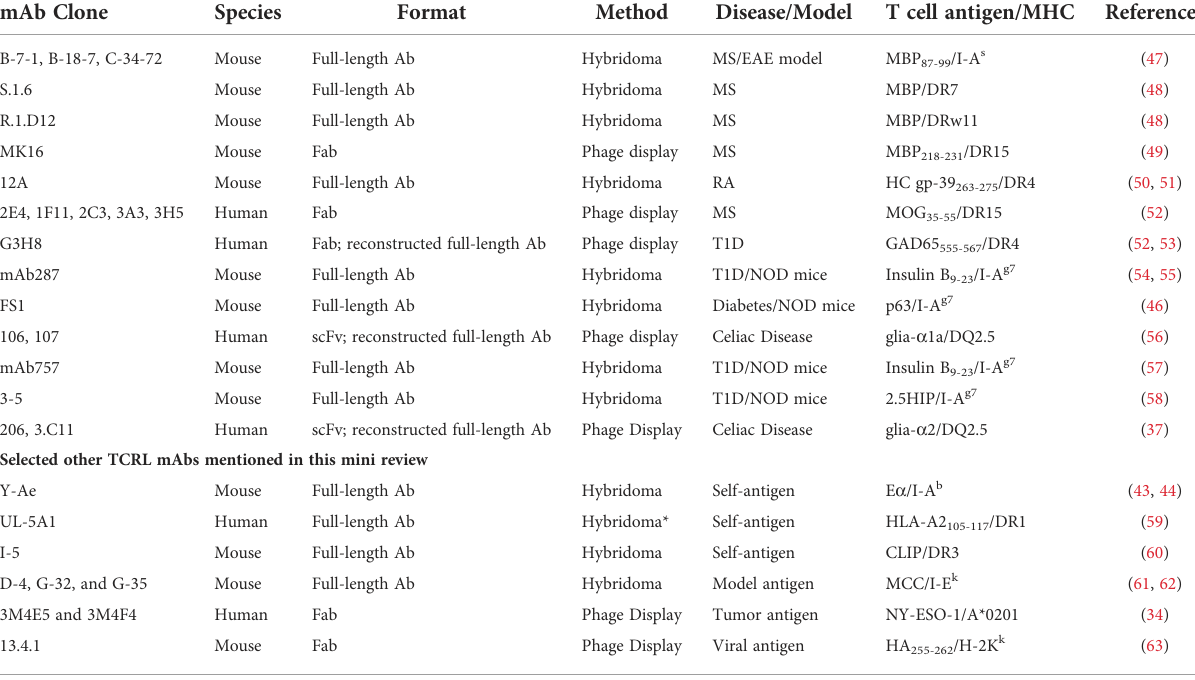
TABLE 1 TCRL mAbs targeting autoimmunity-related p/MHC-II